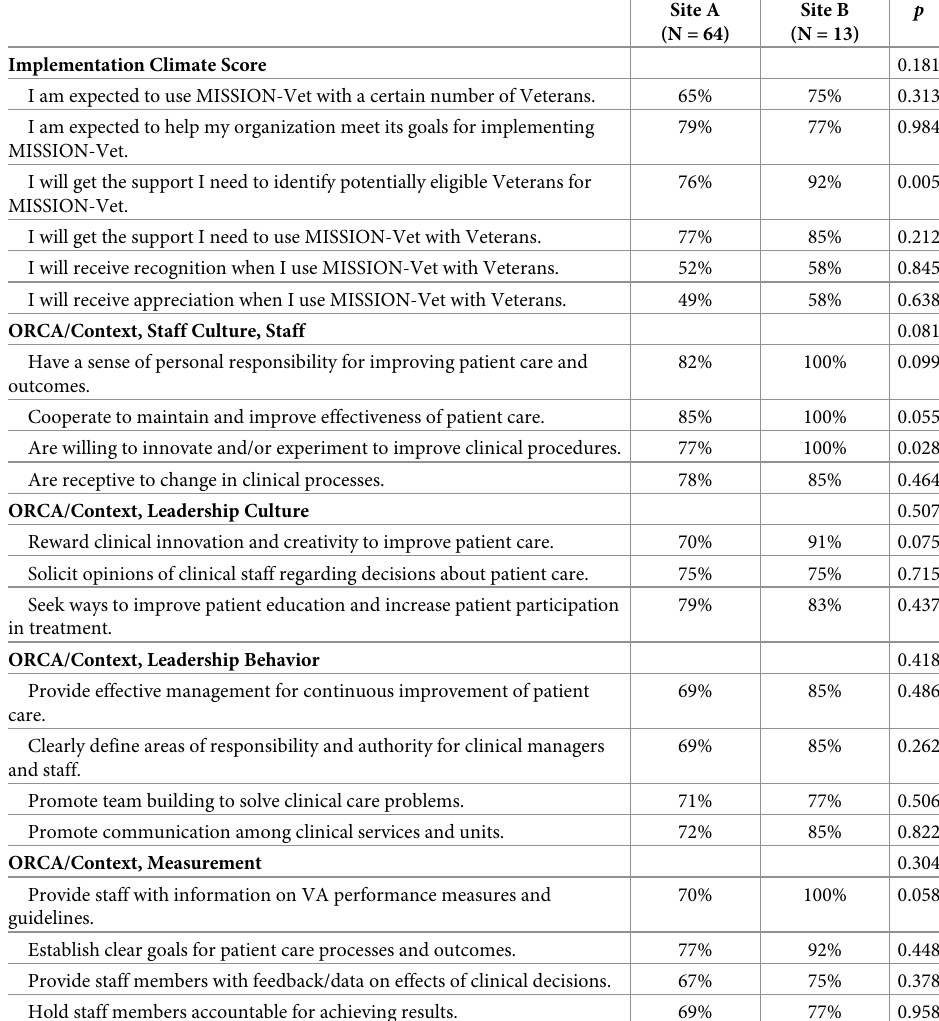
Table 1. Organizational readiness scores by site, N =